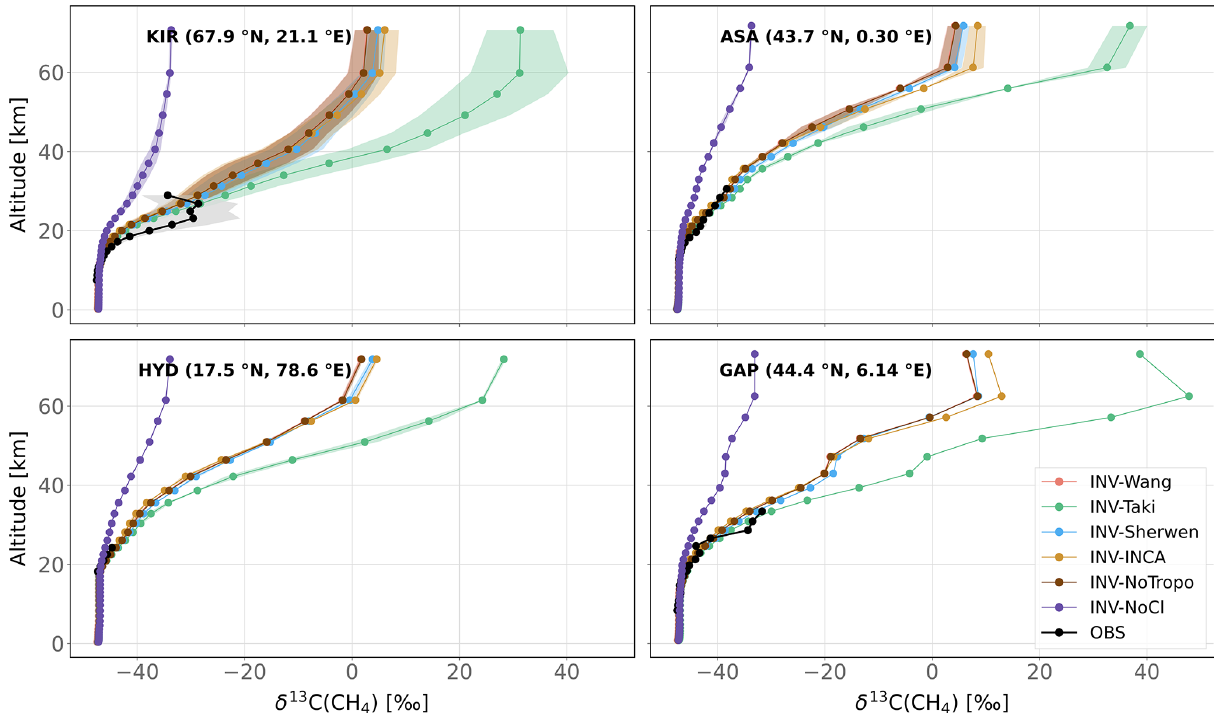
Figure 5. Observed and simulated δ 13 C(CH 4 ) vertical profiles for four locations. All available vertical profiles in each region have been averaged. Shaded areas indicate the standard deviations of this average. Note that measurement uncertainties (around 0.2‰) are much lower than the x axis range. KIR is Kiruna, Sweden (67.9 ◦ N, 21.10 ◦ E), ASA is Aire-sur-l’Adour, France (43.70 ◦ N, 0.30 ◦ E), HYD is Hyderabad, India (17.5 ◦ N, 78.60 ◦ E), and GAP is Gap, France (44.44 ◦ N, 6.14 ◦